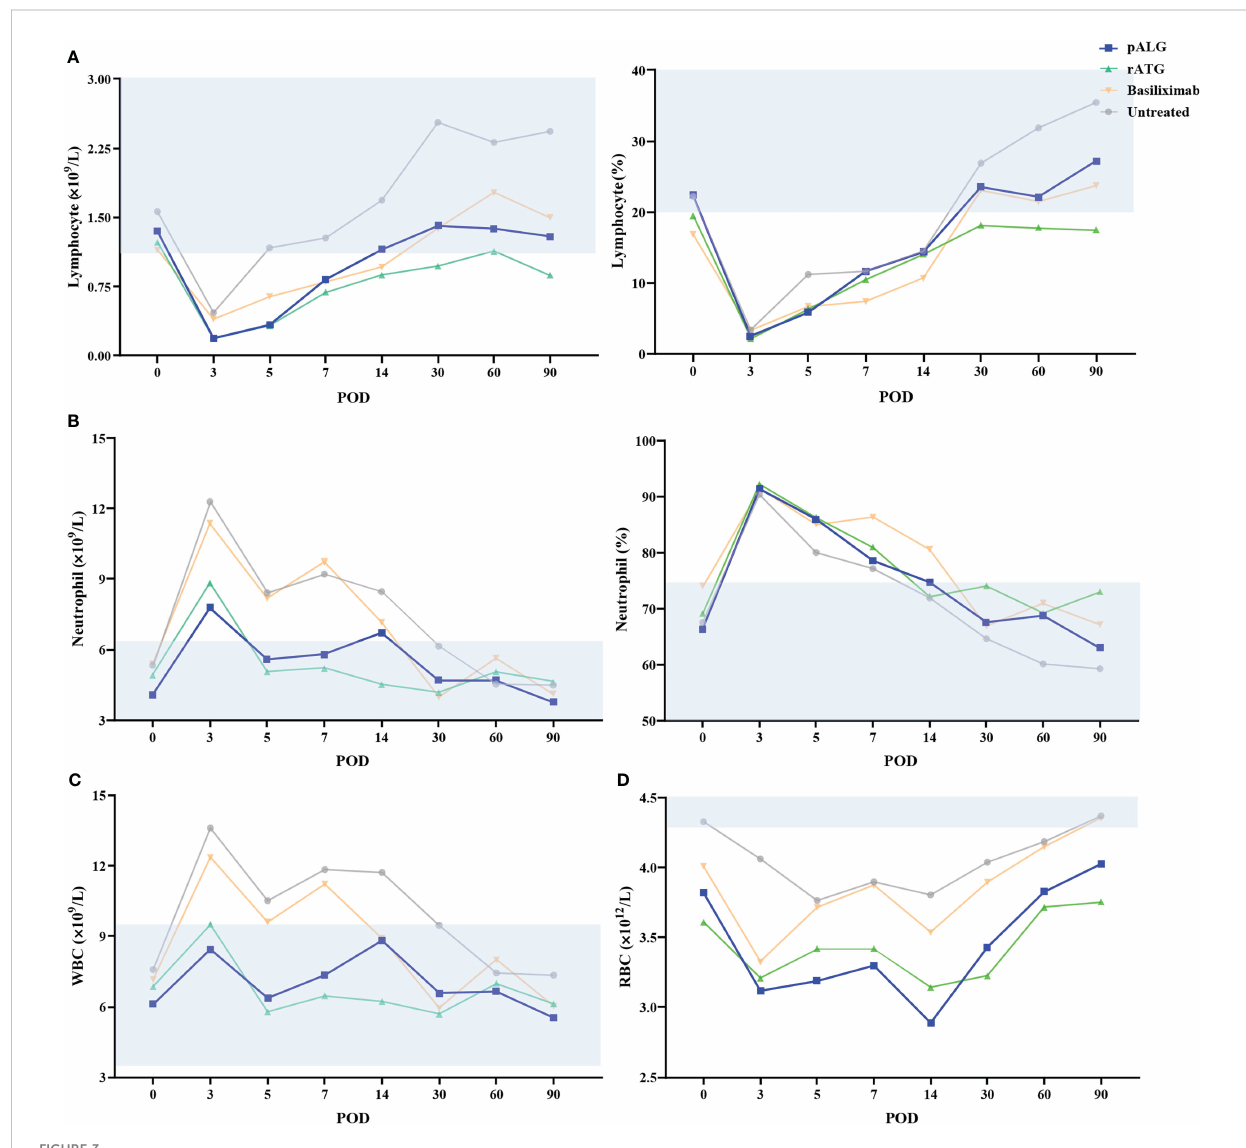
FIGURE 3 Changes in routine blood tests during the 3 months of follow-up. (A) The number and proportion of lymphocytes. (B) The number and proportion of neutrophils. (C) The number of WBC. (D) The number of RBC. Shaded area represents the normal range. WBC, white blood cell. RBC, red blood cell. POD, postoperative